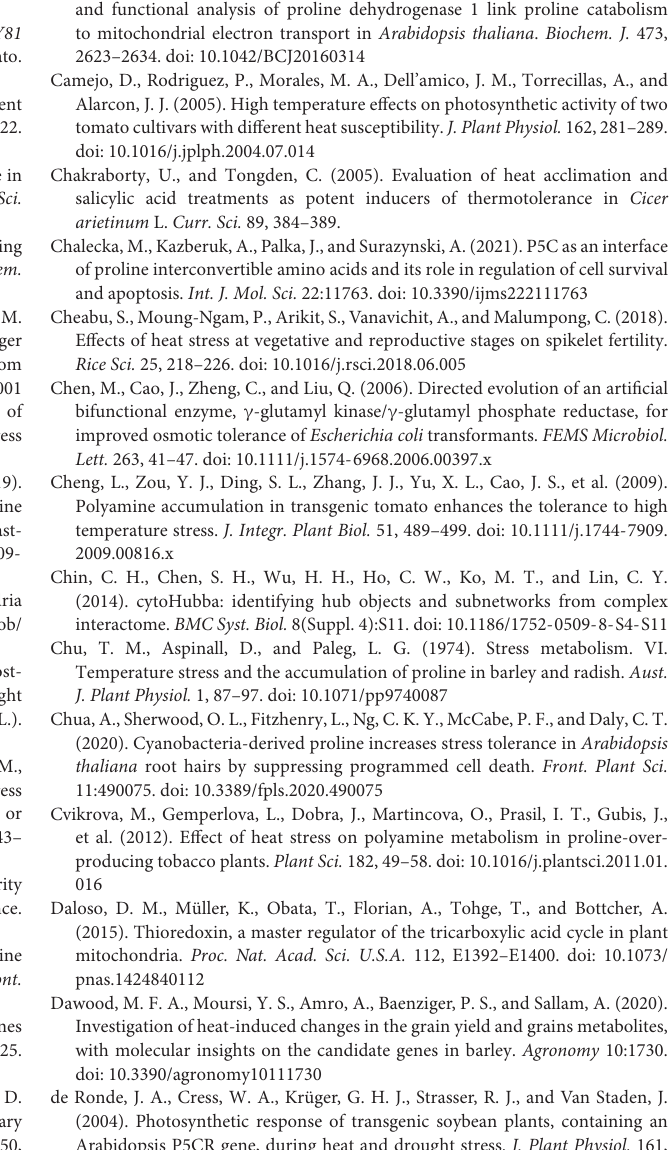
Figure 1 is revised by Rhowell N. Tiozon, to ensure good